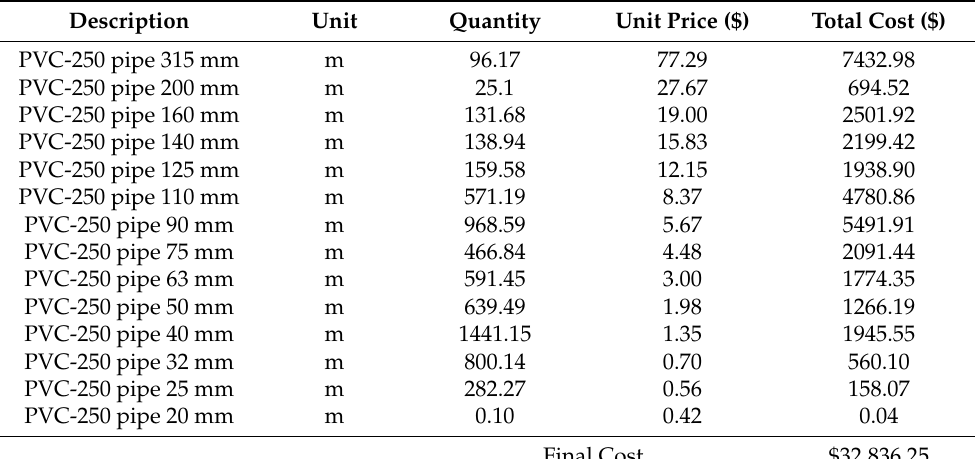
Table 6. Referential budget for the design of the Tuncarta network with Genetic Algorithm.